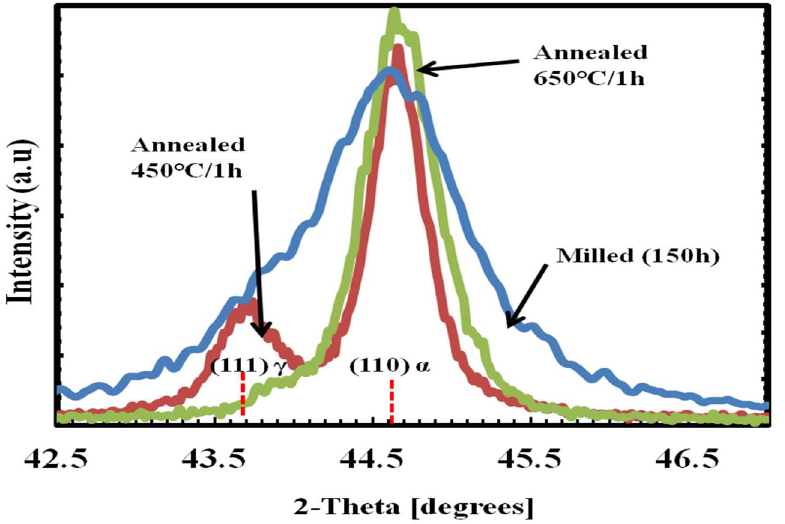
Figure 9. Details of the most intense peak BCC Fe (110) of the of the Fe 70 Ni 12 B 16 Si 2 alloy after mechanical alloying and annealing.